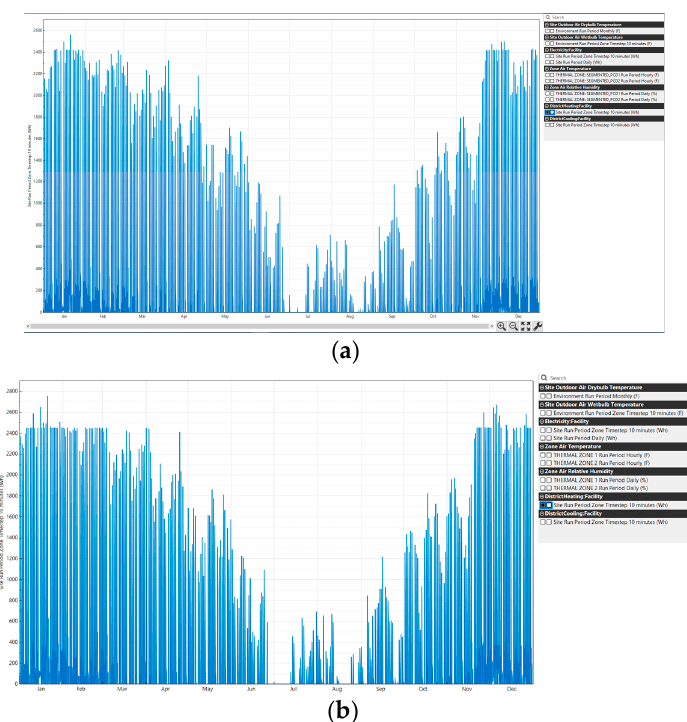
Figure 24. Comparison between heating consumption along a year for scenario 3: ( a ) Estimated model; ( b ) Manually generated model.